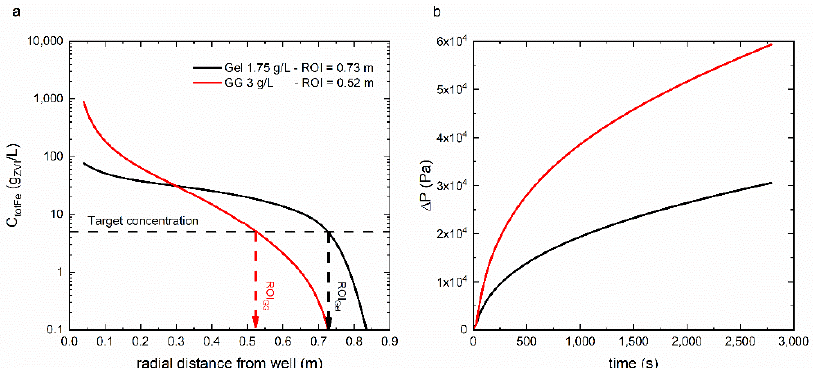
Figure 4. Simulation results for microscale iron (mZVI) particles stabilized through the gel and mZVI particles dispersed in GG only: ( a ) total iron concentration profiles, ( b ) the variation of pressure over time measured at 7 cm from the injection well.